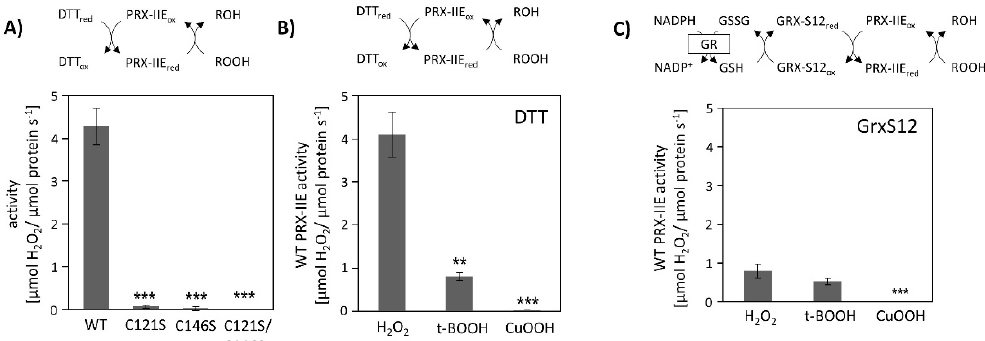
Figure 2. Peroxidase activity. ( A ) Peroxide reduction by wild-type PRX-IIE and its cysteine variants was measured with 400 µ M H 2 O 2 , 4 mM DTT, and 2 µ M protein. The decrease in H 2 O 2 was quantified using the FOX assay. Data are means ± SD, n = 30 with protein of three independent protein purifications. ***: p < 0.001. ( B ) Substrate specificity was tested with the FOX assay with 4 mM DTT as reductant and different peroxides (400 µ M H 2 O 2 , 200 µ M t-BOOH, or 200 µ M CuOOH). Data are means ± SD, n = 18–28 with protein from three independent protein purifications. **: p < 0.01; ***: p < 0.001. ( C ) PRX-IIE activity in the presence of GRX-S12 as monitored by NADPH oxidation at 340 nm in an enzyme-coupled assay. Data are means ± SD, n = 9 with protein from three independent protein purifications. **: p < 0.01; ***: p < 0.001.